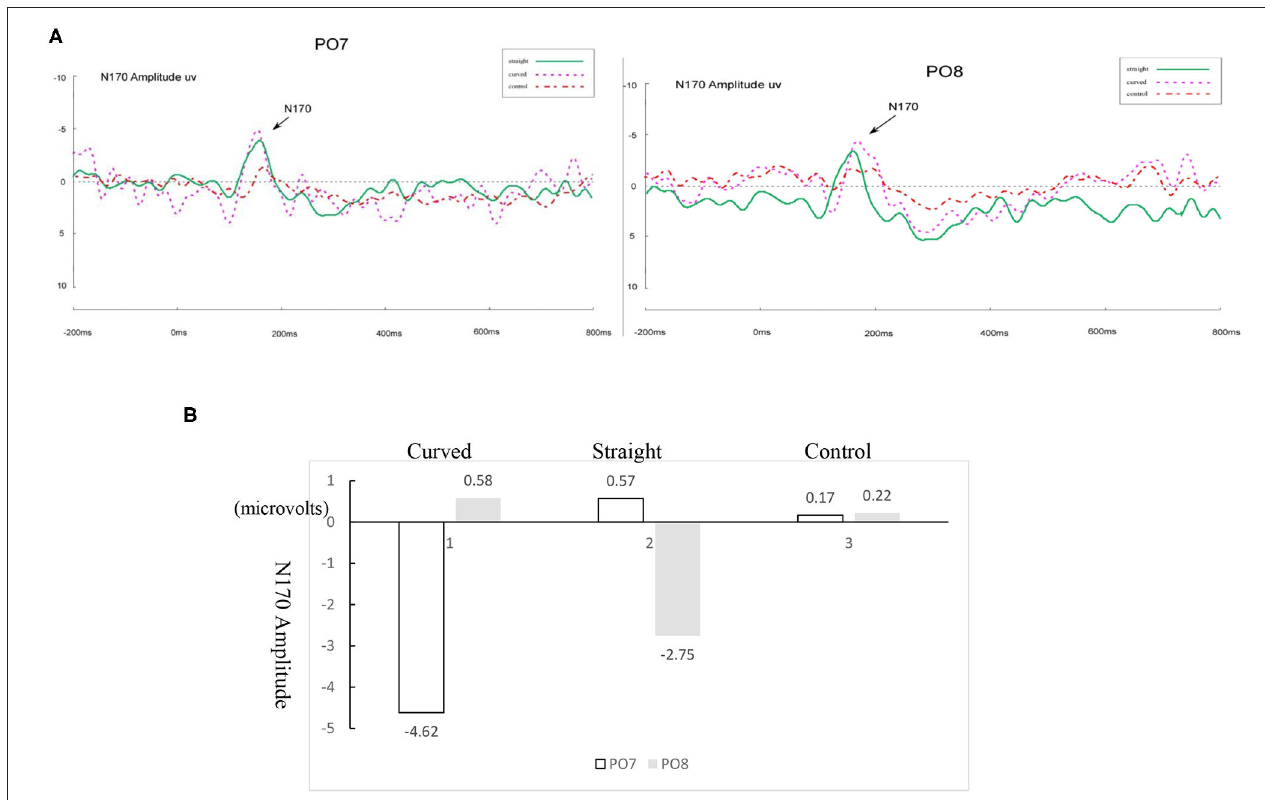
FIGURE 8 | (A) ERP waveforms of N170 under straight, curved control drawing English condition for dyslexic readers for the left (PO7) and right (PO8) parietal leads. (B) Differences between three conditions for dyslexic readers in the amplitude of N170.